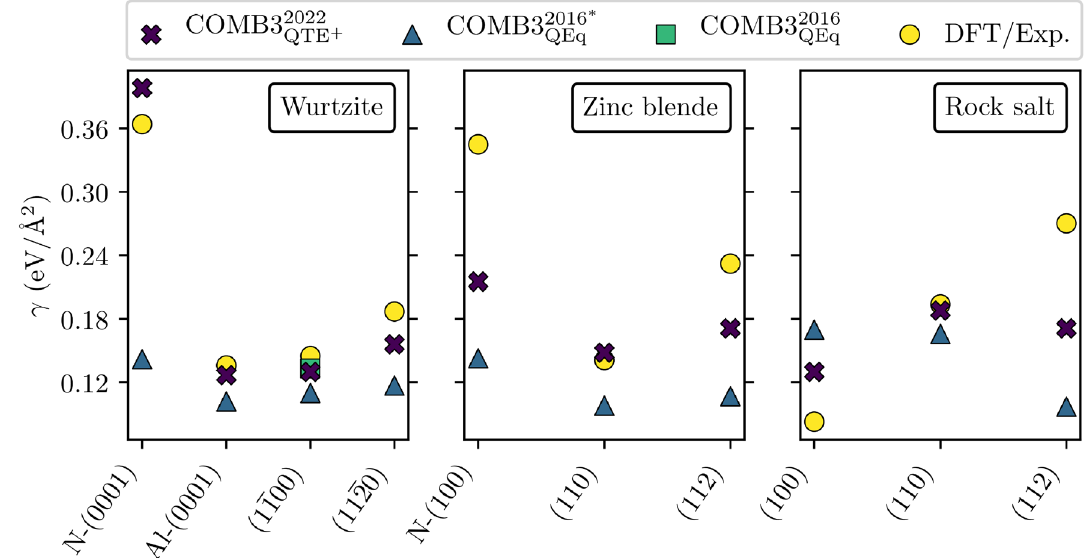
and COMB3 2016 ∗ QEq are compared to the COMB3 2016 QEq QTE +